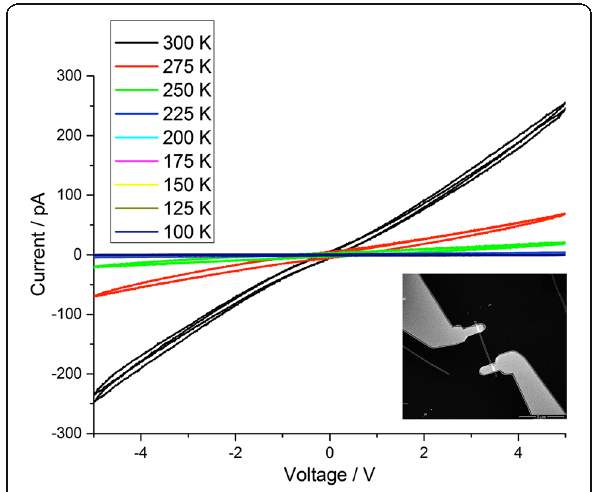
Fig. 5 I – V curves of SiNWs contacted with the EBL method at different temperature (from 100 to 300 K). Each curve represents two voltamperogrames cycles. A little hysteresis is detectable as well as a slight instability of the curves. In the inset , a SEM image of the measured SiNW